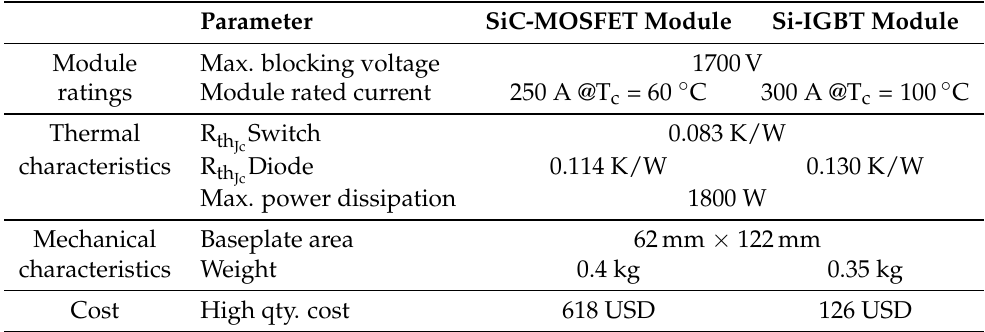
Table 2. SiC-MOSFET and Si-IGBT module main